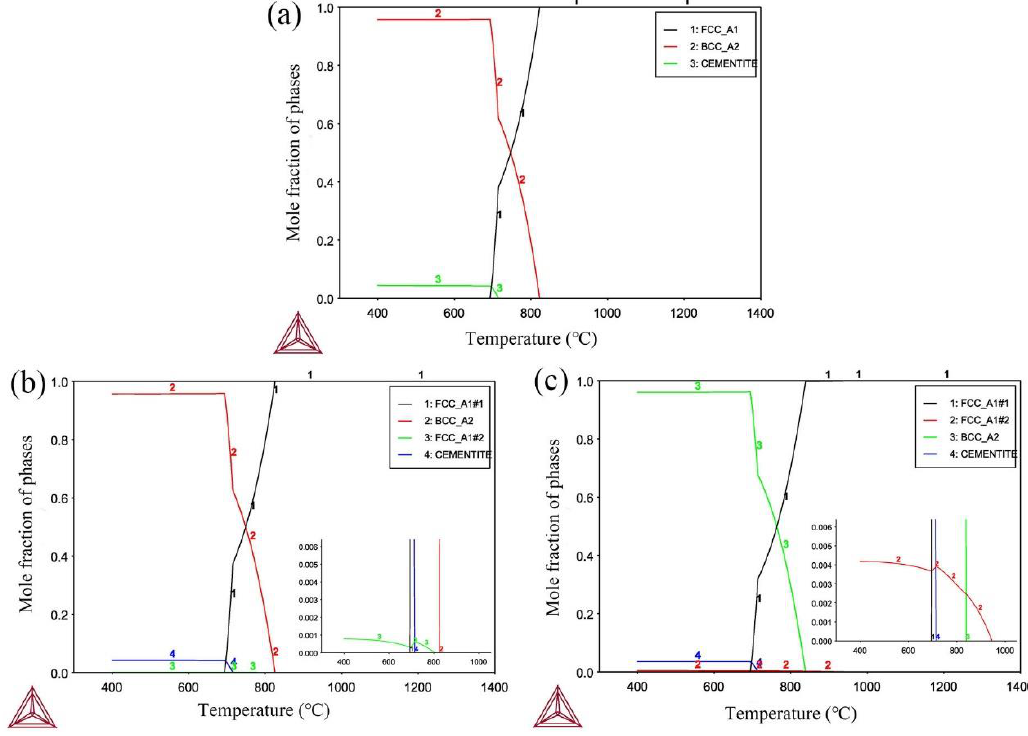
where 𝐼 𝛾 and 𝐼 𝛼 are the integrated intensities of austenite and ferrite, respectively. In the present work, the diffraction lines of (200) α , (211) α , (200) γ , (220) γ , and (311) γ were employed to determine the value of 𝑉 𝛾 [27]. Figure 1. The equilibrium phase diagrams: ( a ) 0V, ( b ) 0.03V and ( c ) 0.16V.